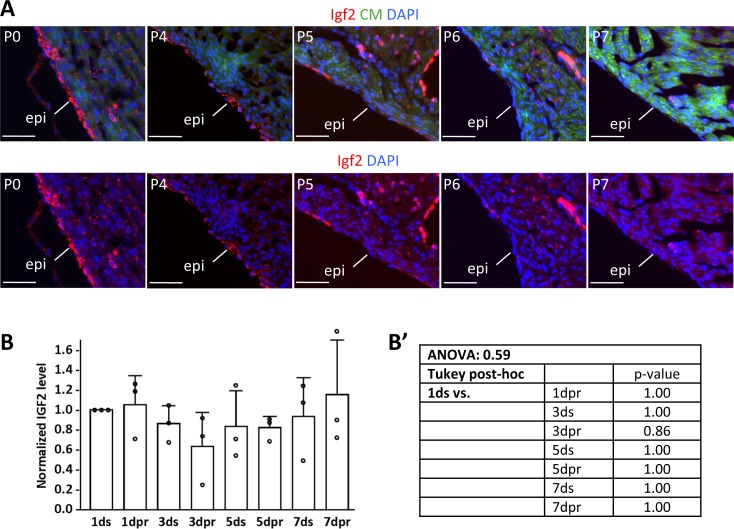
Neonatal IGF2 expression.(A) Igf2 expression detected by in situ hybridization in the uninjured postnatal heart, focusing on the decline of epicardial expression from P4 to P7. The same sections are shown with (upper) and without (lower) the cardiomyocyte staining channel for clarity. Scale bars: 500µ. (B) Quantification from three independent Western blots of IGF2 protein at 1, 3, 5, and 7 days after sham (s) or resection (r) surgery. To allow comparison between blots, the signals from 1 day sham operated hearts were defined as 1.0. (B’) Statistical analysis of the data of panel B.